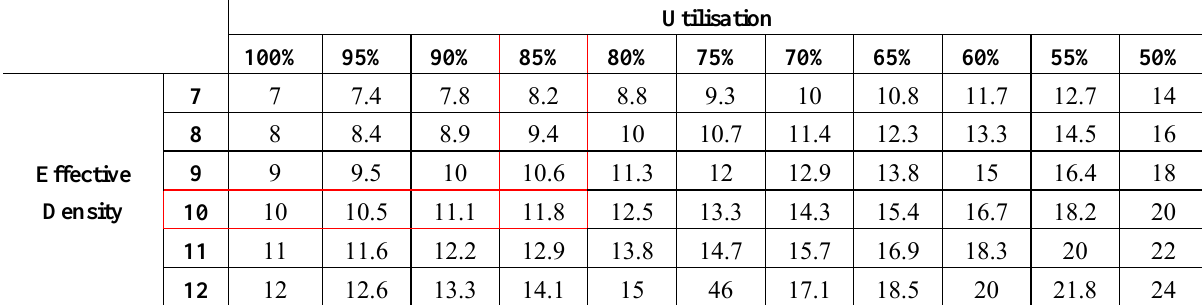
Table 1. Effective density in office buildings in the United Kingdom (m 2 per person). Source: After CIBSE